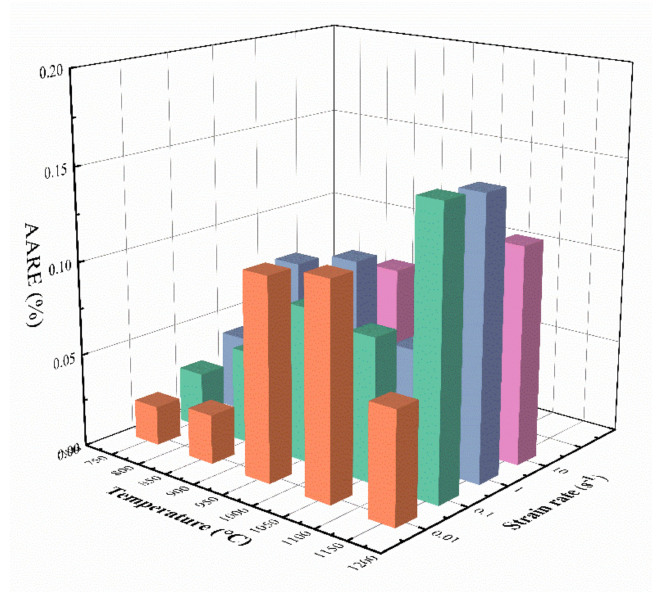
Figure 12. The average absolute relative error ( AARE ).